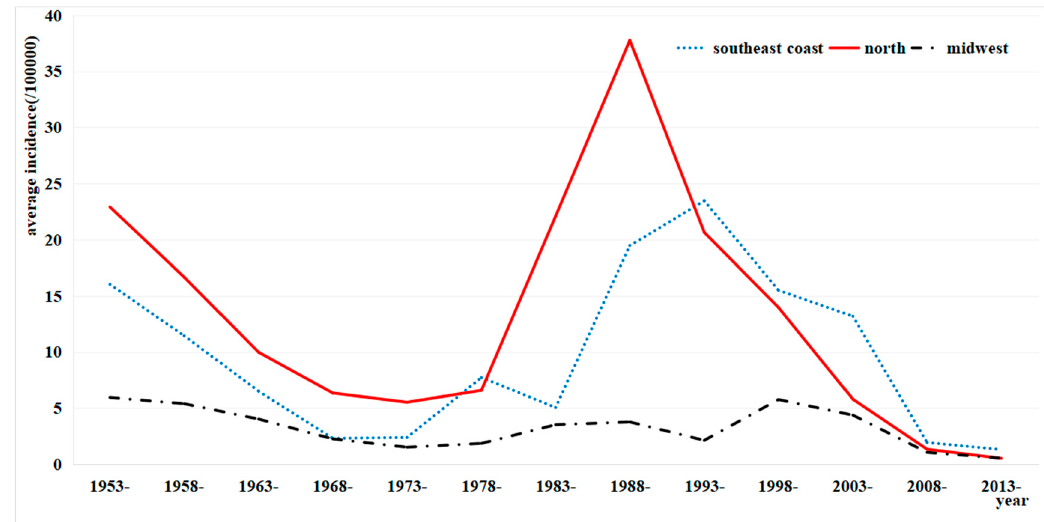
Figure 4. The average annual incidence of typhoid and paratyphoid in three areas in Zhejiang from 1953 to 2014. Table 2. The average annual incidence of typhoid and paratyphoid in all municipalities in Zhejiang from 1953 to 2014 (/100,000).